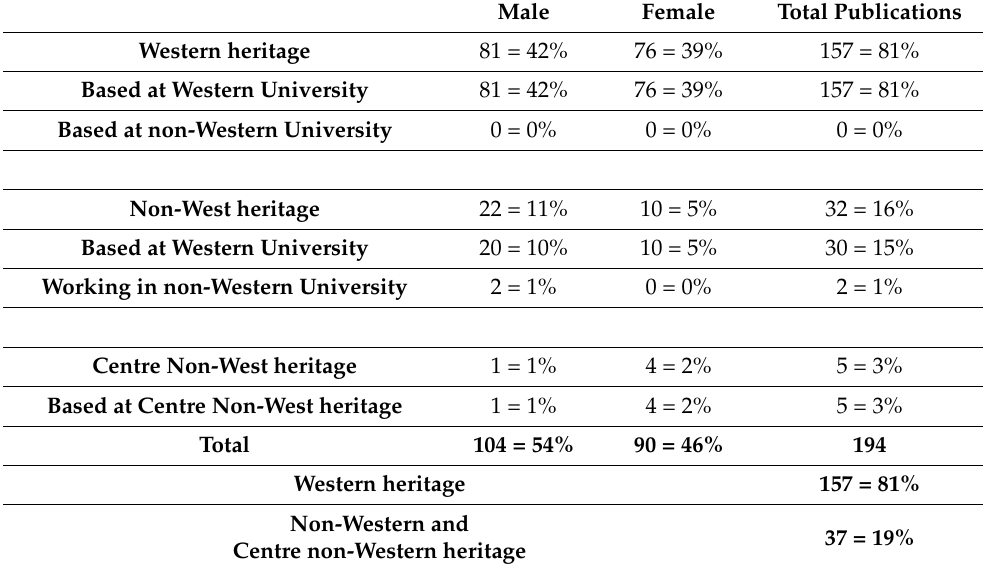
Table A1. Journal analysis—critical studies on